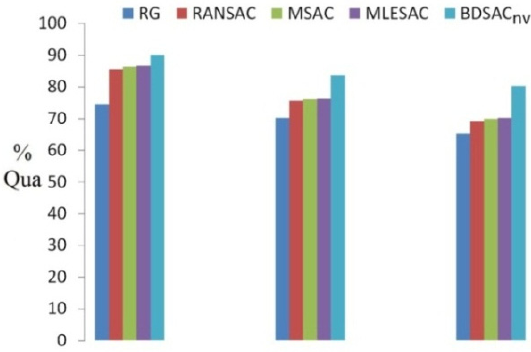
Figure 14. Integral quantitative results. Three metrics are used, from left to right: quality of segmentation and quality of two ridge based metrics.